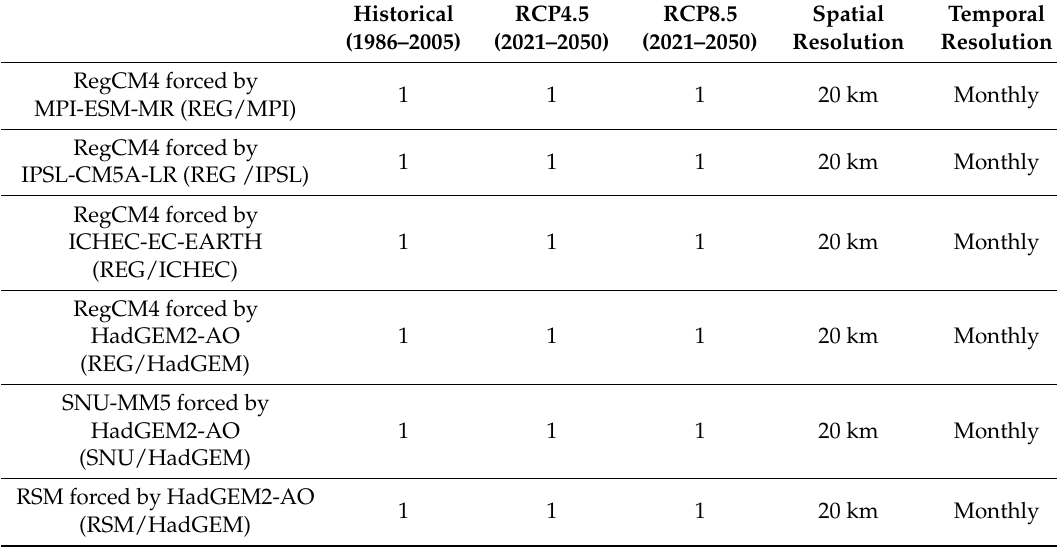
Table 1. Climate models and number of